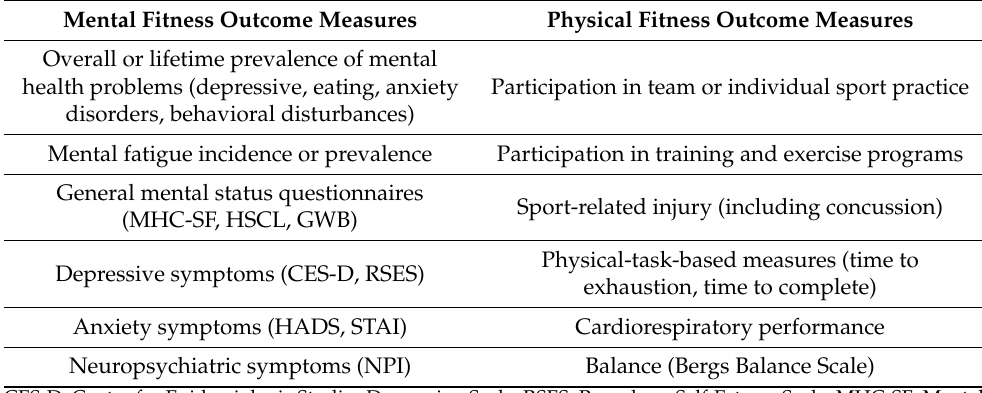
Table 1. Details of outcome measures in studies considered for